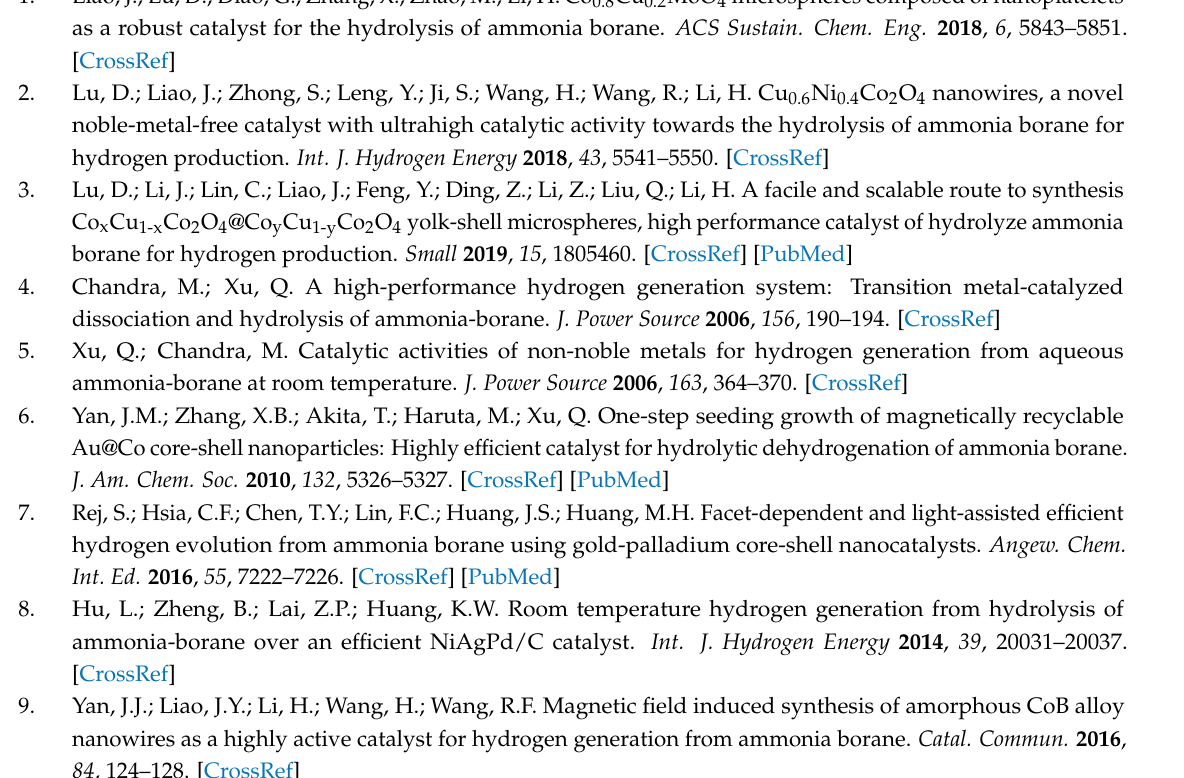
Figure S1: SEM images of the sample prepared in the absence of ethanolamine and the sample prepared by using sodium citrate instead of ethanolamine as complexing agent, Figure S2: Effect of NaOH concentrations on the viscosity of the medium, Figure S3: SEM image of the CuCo 2 O 4 nanoplatelets after catalytic